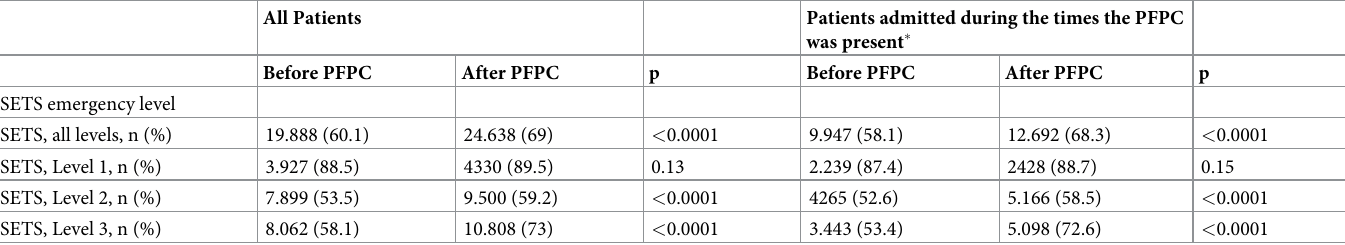
Table 2. Number and proportions of patients evaluated within SETS time limits before and after introducing the patient-flow physician coordinator. All